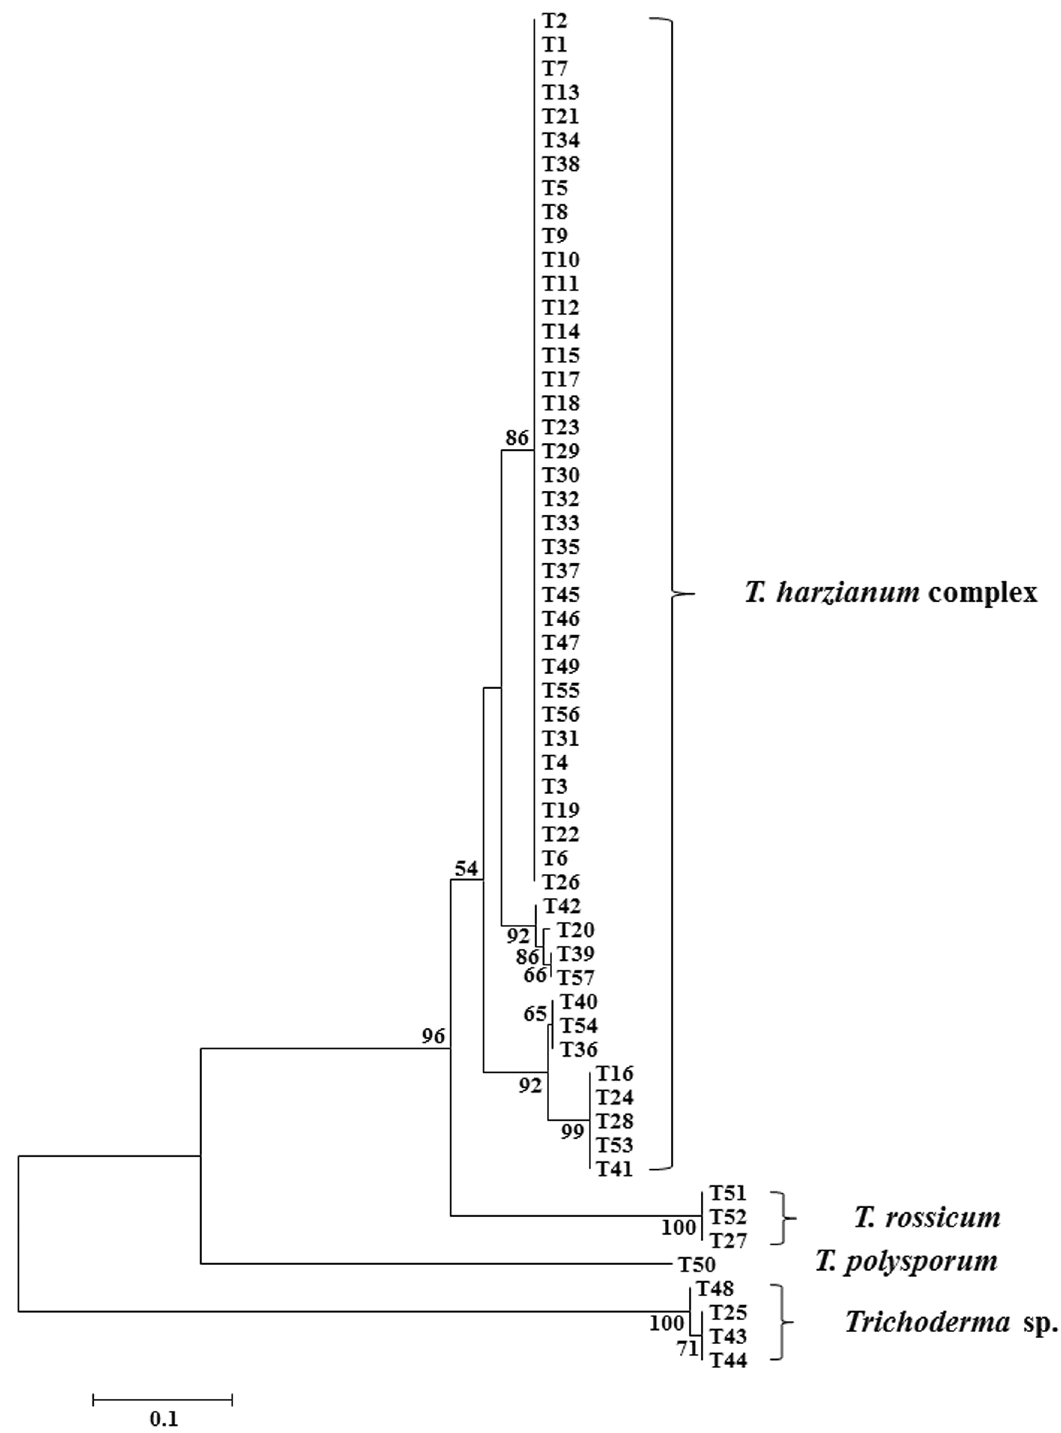
Figure 1. Neighbor-joining tree based on partial gpd gene sequences from 57 Trichoderma isolates. Parsimony bootstrap values of more than 50% are shown at